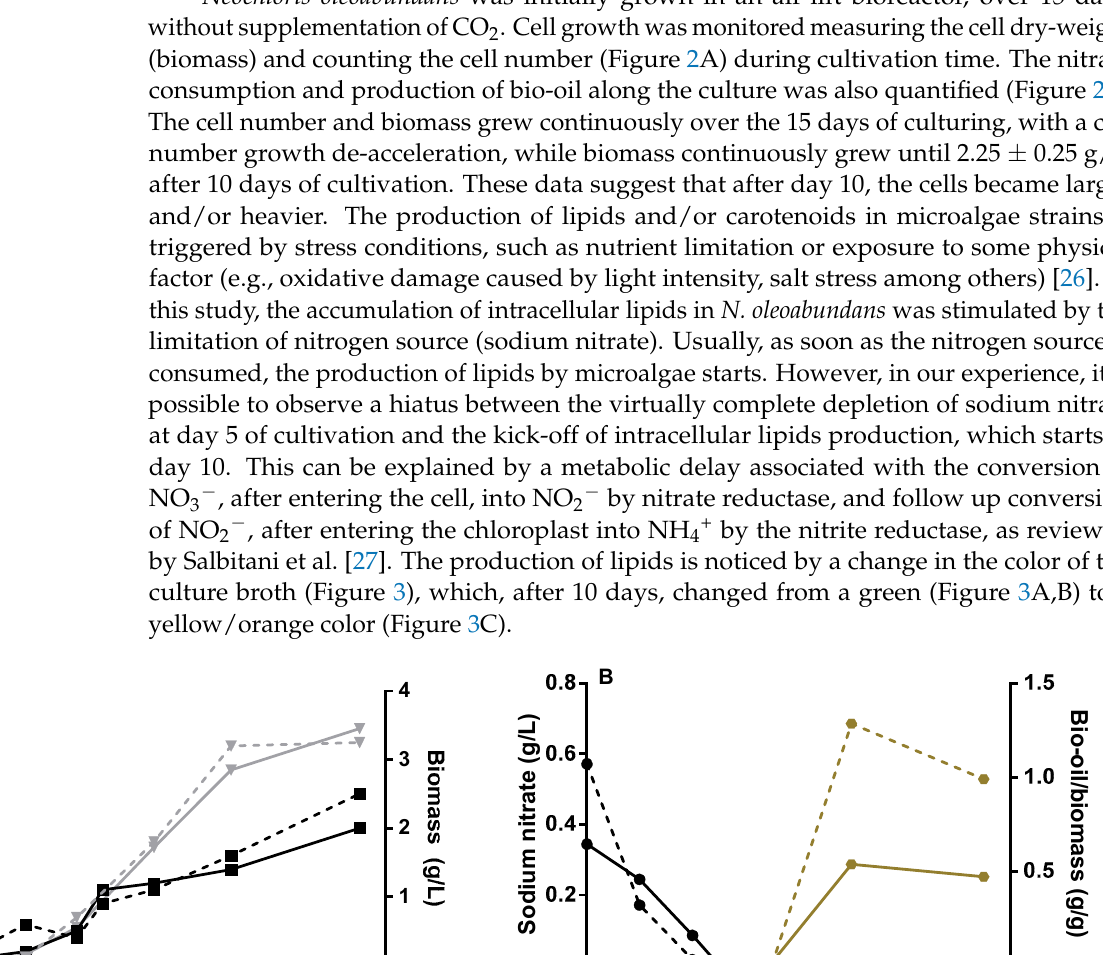
Figure 3. Images of Neocloris oleoabundans #1185 cultivation in air-lifts bioreactors at day 0 ( A ), 5 ( B ) and 15 ( C ) of fermentation.